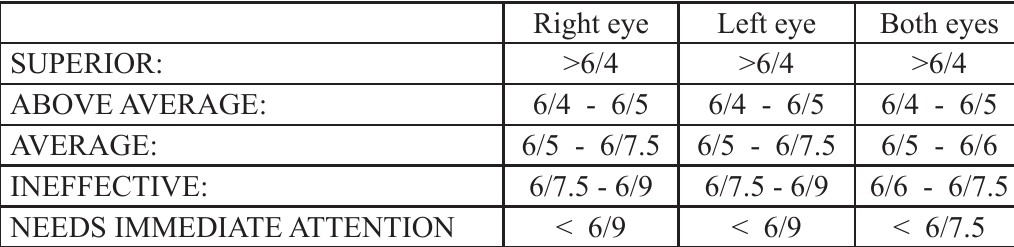
Table 2: The norms for Dynamic (kinetic) Visual Acuity as obtained with a Wayne Tachistoscope rotator